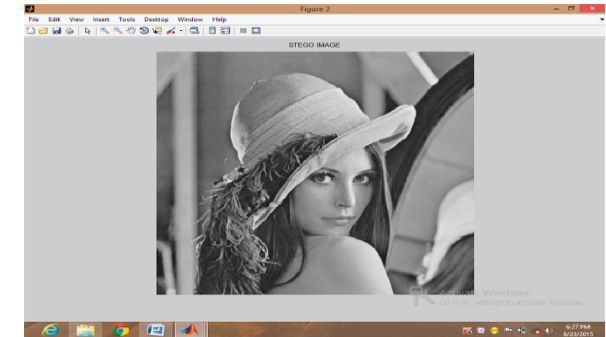
Figure 20: Stego image of Lena.